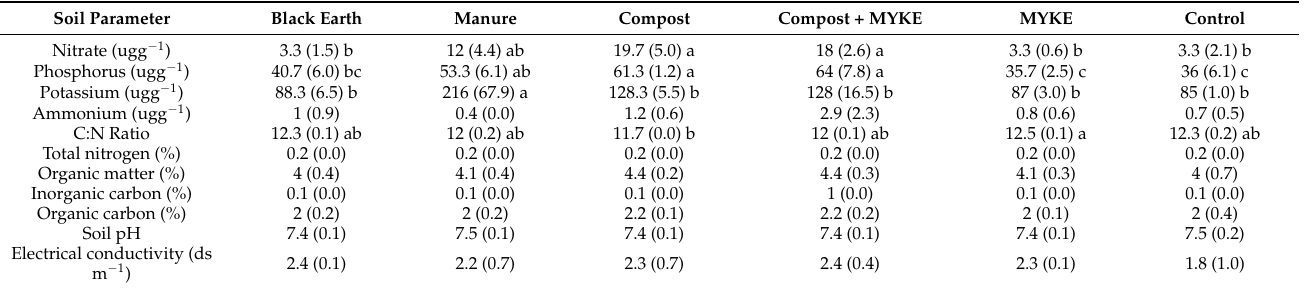
Table 1. Mean ( ± SE) soil properties for each soil amendment treatment at the reclamation site of phosphogypsum